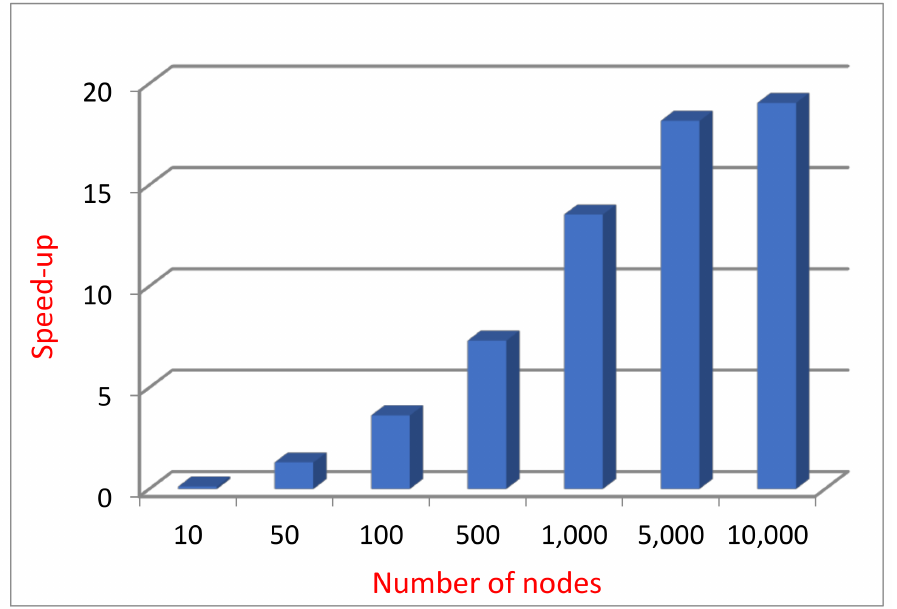
Figure 4. Speed-up